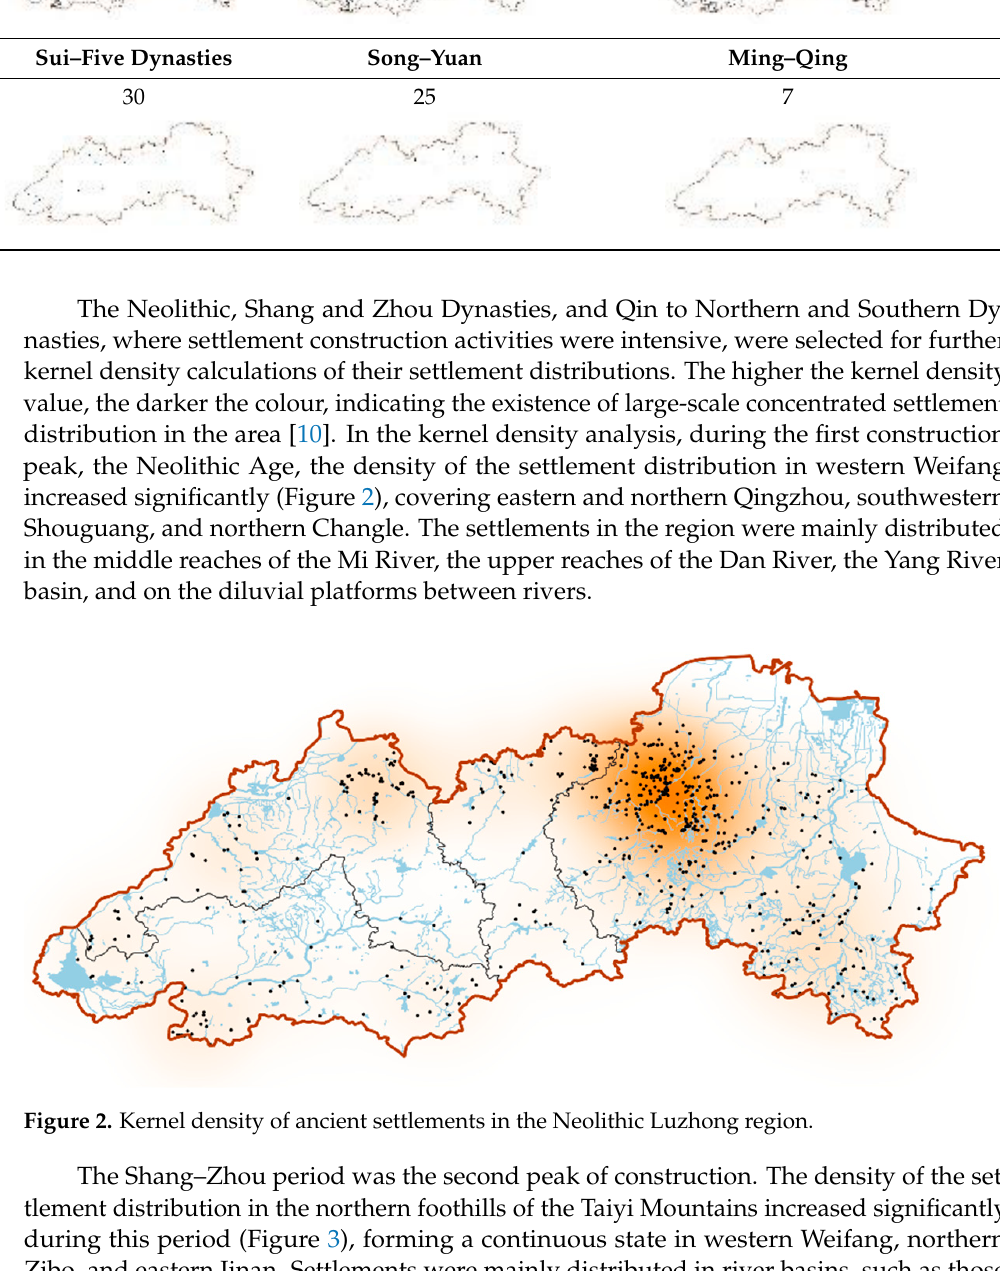
Figure 2. Kernel density of ancient settlements in the Neolithic Luzhong region. The Shang–Zhou period was the second peak of construction. The density of the set- tlement distribution in the northern foothills of the Taiyi Mountains increased significantly during this period (Figure 3), forming a continuous state in western Weifang, northern Zibo, and eastern Jinan. Settlements were mainly distributed in river basins, such as those of the Mi River and the Xiaofu River, as well as in the diluvial platforms and alluvial plains between rivers. Meanwhile, there was a slight increase in density in the southwestern part of the Luzhong